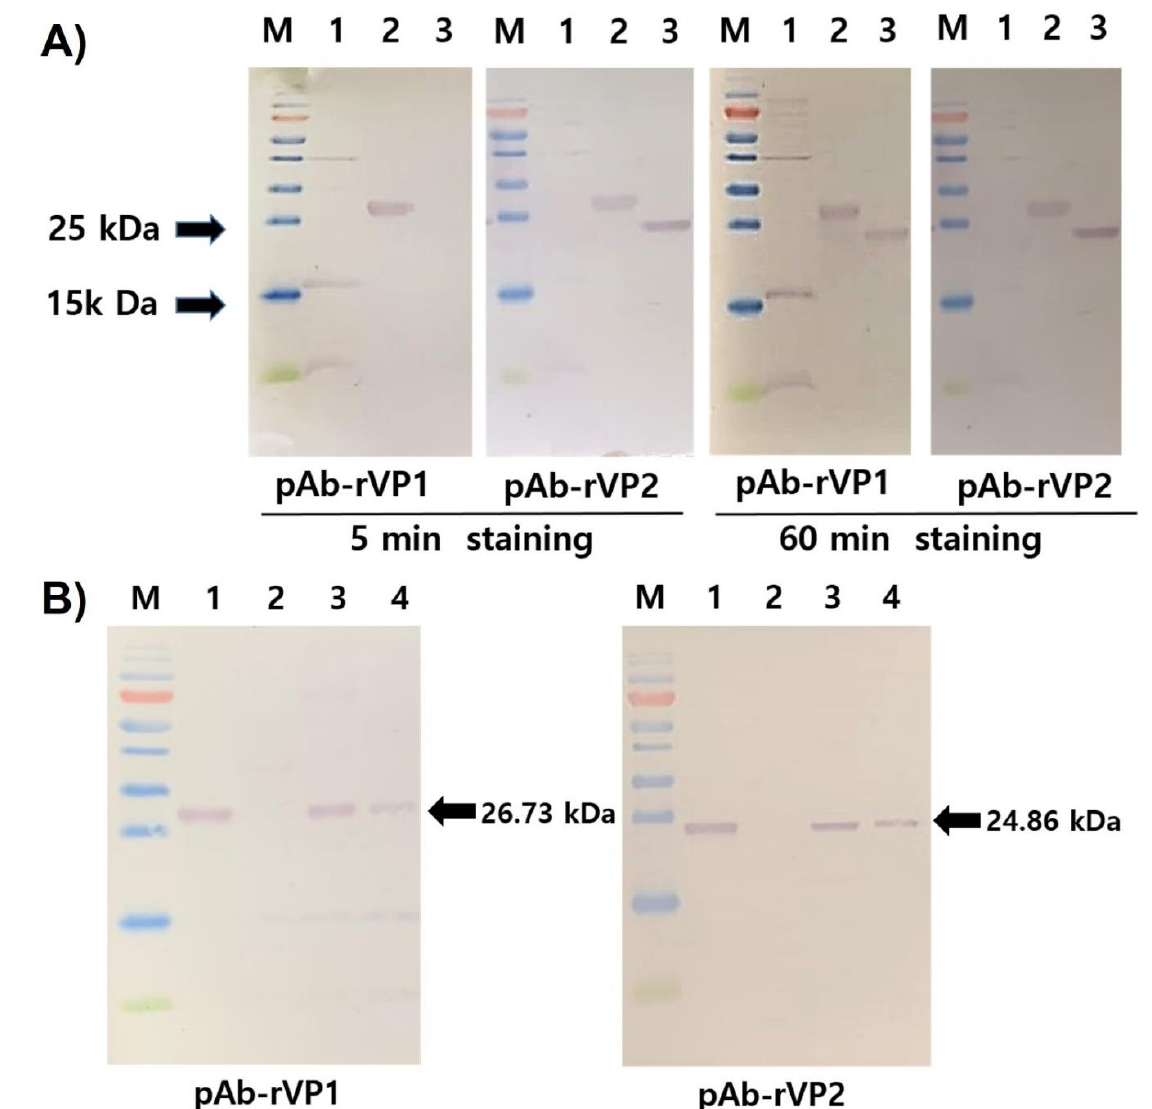
Figure 3. ( A ) Western blot analysis of rVP1 and rVP2 (lanes 1–3, 5 µ g each) using pAb-rVP1 and pAb-rVP2 and ( B ) Western blot analysis of rVP1, rVP2 (lane 1, 5 µ g each), crude protein extract from healthy honeybees (lane 2, 20 µ g), crude protein extract from AcSBV-infected honeybees (lane 3, 20 µ g), and AcSBV-infected larvae (lane 4, 20 µ g) using pAb-rVP1 (left) and pAb-rVP2 (right).